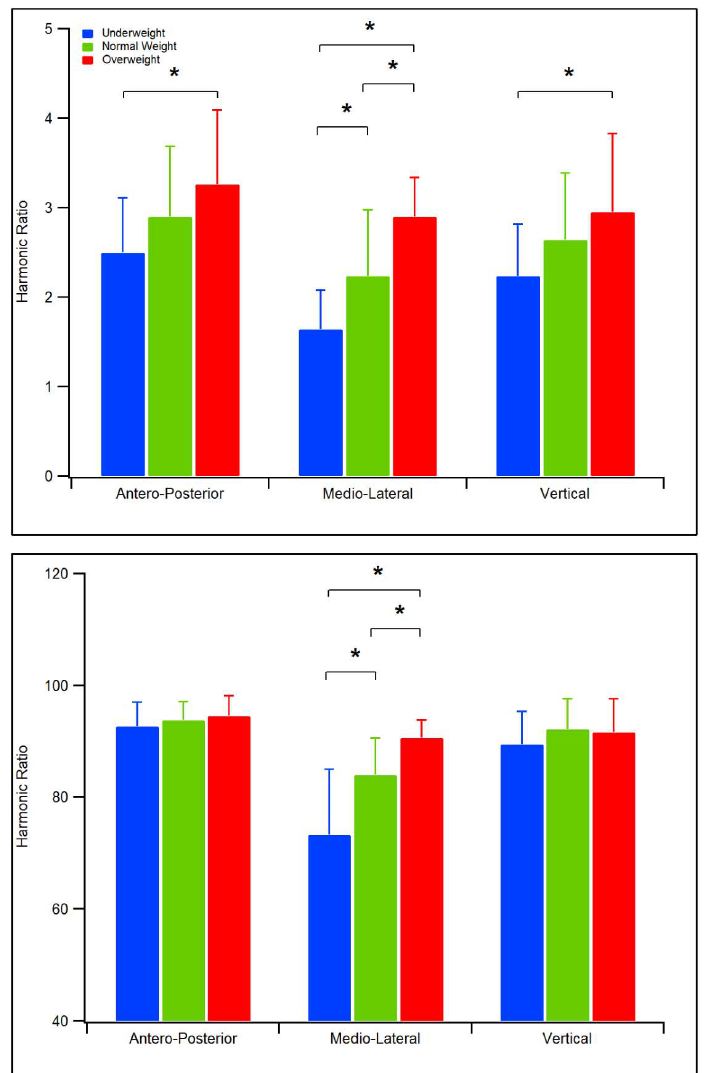
Figure 1. Trend of HR values for underweight, normal weight and overweight children. Top: values calculated according to the procedure described by Menz et al. [26]. Bottom: values calculated according to the procedure described by Pasciuto et al.